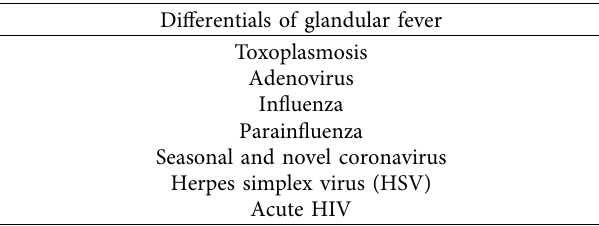
Table 1: Important mimics of glandular fever [2, 11,